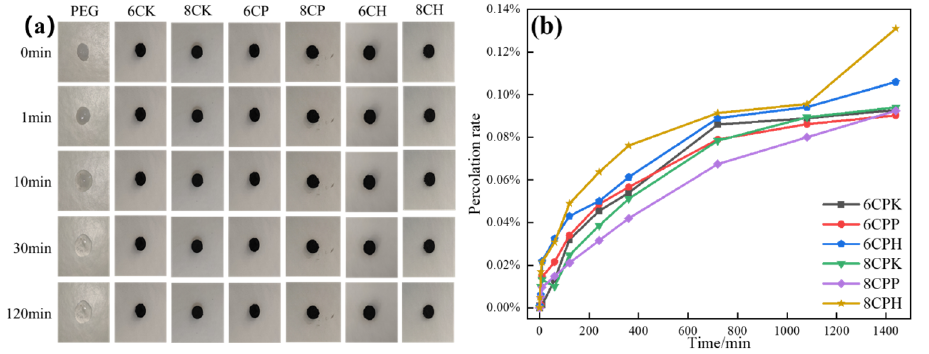
Figure. 8 ( a ) Leakage of the composites and PEG at 30 °C; ( b ) leakage rate of the prepared compo- Figure 8. ( a ) Leakage of the composites and PEG at 30 ◦ C; ( b ) leakage rate of the prepared sites.